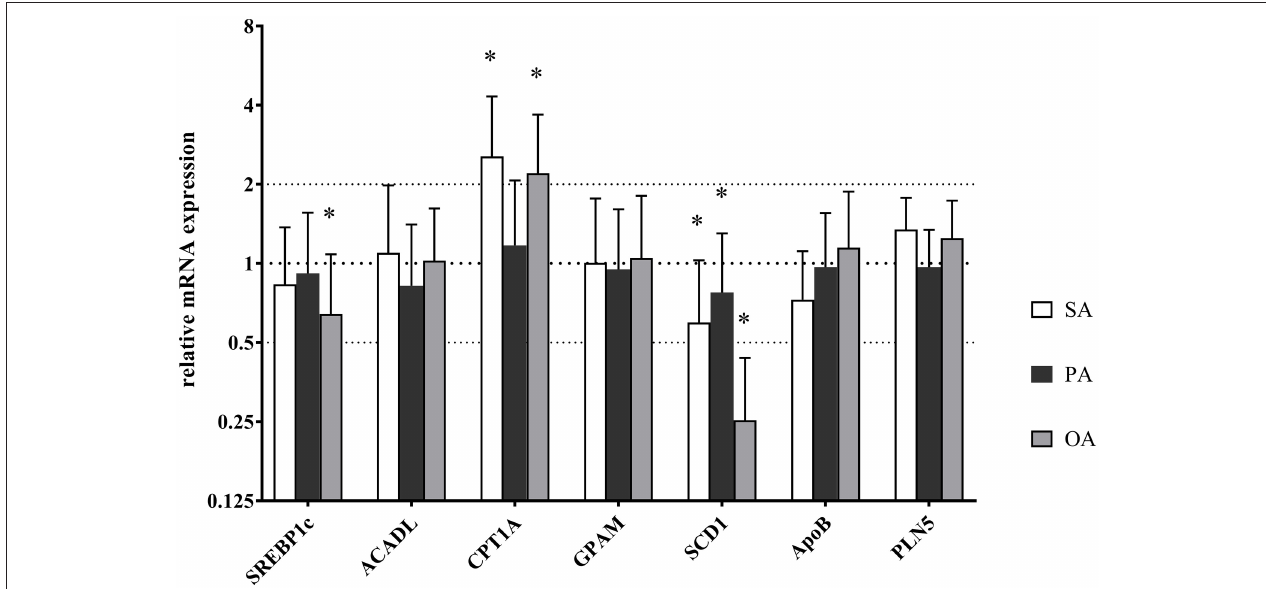
FIGURE 7 | Relative mRNA expression of key enzymes in lipid metabolism after treatment with palmitic acid (PA), stearic acid (SA), or oleic acid (OA). Each value was normalized to GAPDH and SDHA expression. Error bars indicate standard error. Significant differences (* p < 0.05) between PA, SA, and OA were calculated in relation to the control (mRNA expression =